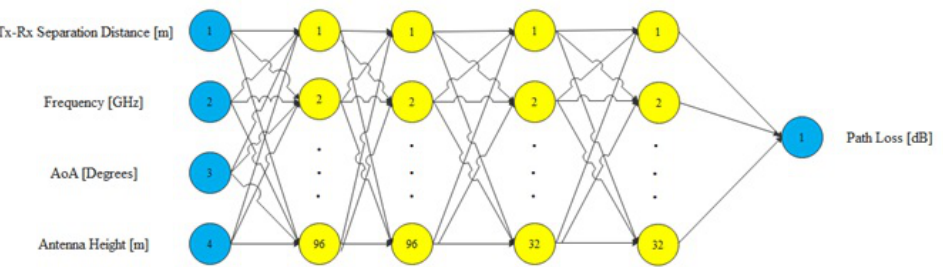
Figure 4. The architecture of the proposed ANN model.